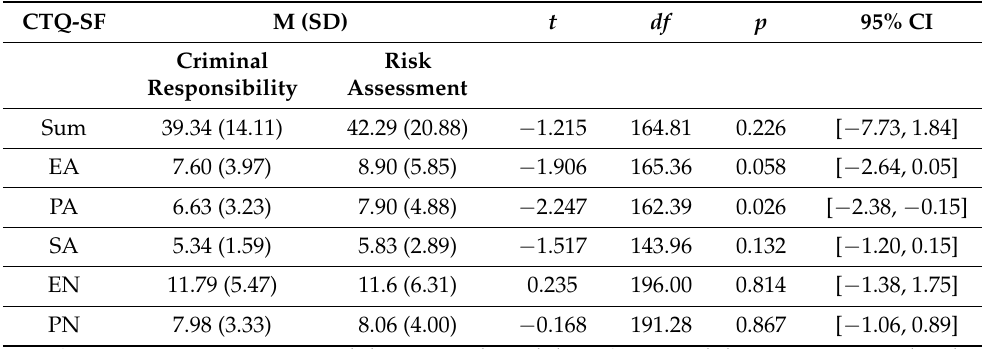
Table 7. Comparison of the Mean External Assessment Scores between the Criminal Responsibility ( n = 131) and Risk Assessment ( n = 100)